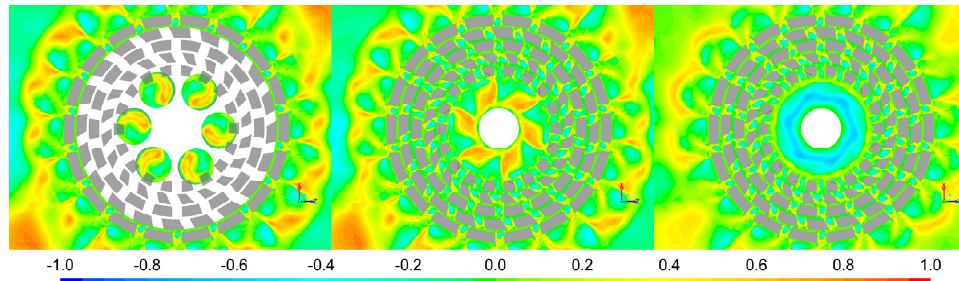
Figure 7. Dimensionless flow parameter α at 6000 rpm for the same planes as in Figure 4.